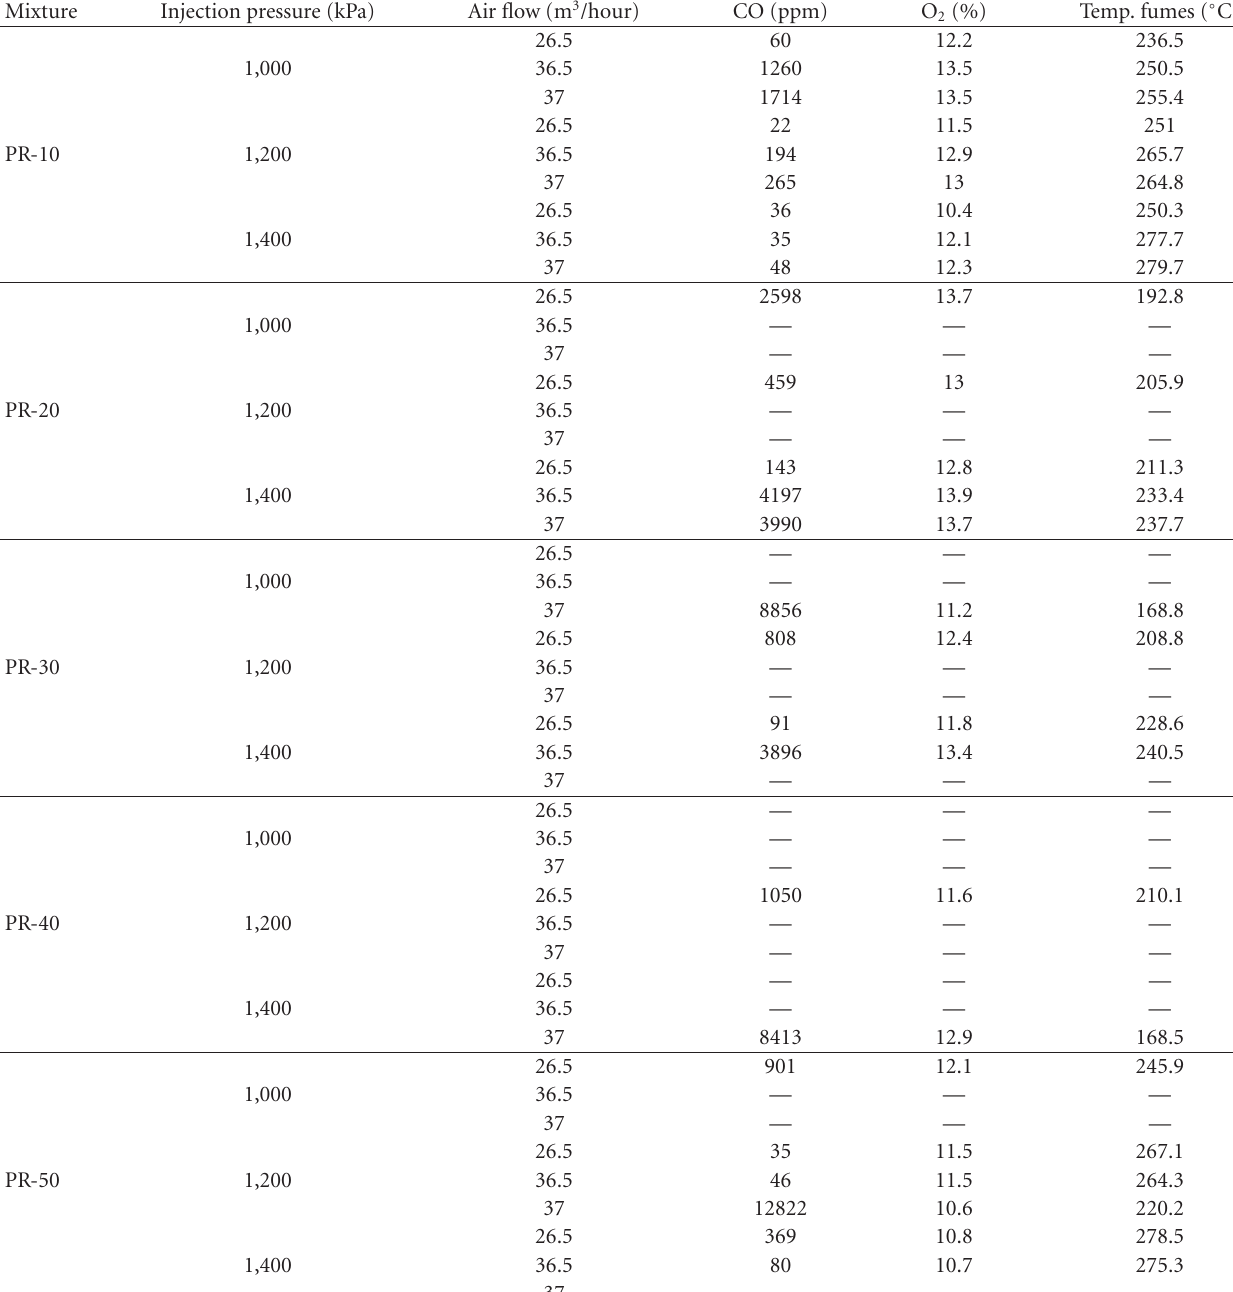
Table 9: Results obtained in the combustion of diesel and lard mixture.